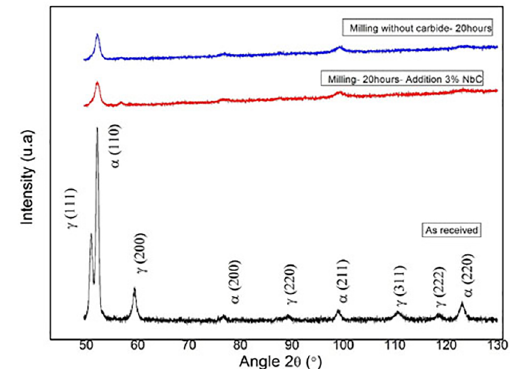
Figure 8. Diffractogram of stainless steel duplex UNS S31803 under the conditions: (a) as received; (b) after 20 hours of grinding without carbide; (c) after 20 hours of milling with addition of 3% NbC.